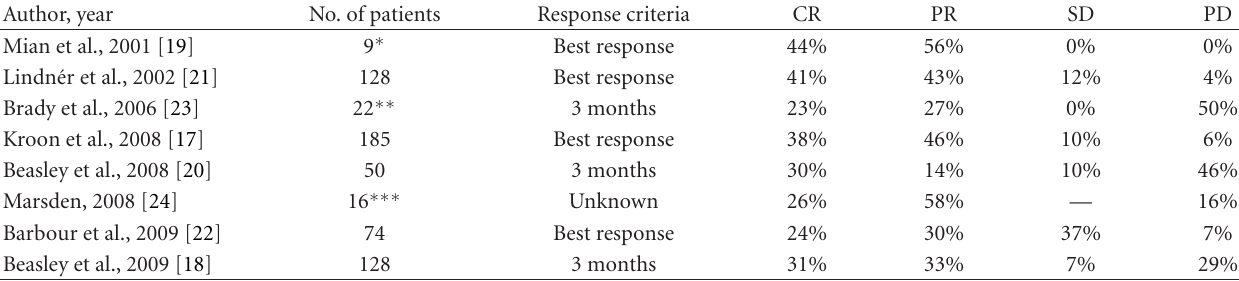
Figure 3: (a) Extensive in-transit melanoma metastases of the left lower leg before ILI. (b) Remission 4 weeks post-ILI. (c) Complete response 4 months post-ILI. Table 2: Isolated limb infusion studies using melphalan and actinomyocin-D